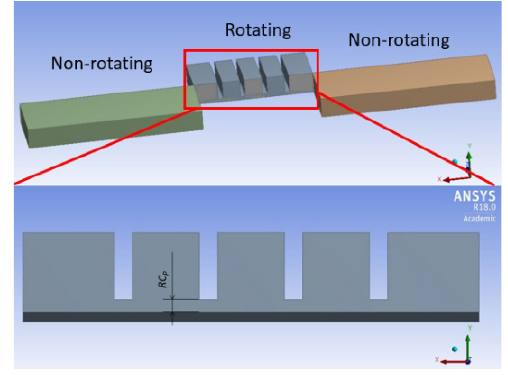
Figure 1. Geometry